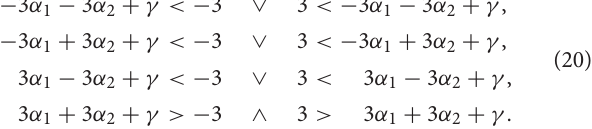
Figure 4 . The complete list of the system parameters that we used to remark that in all the cases κ = 3 and α 1 =